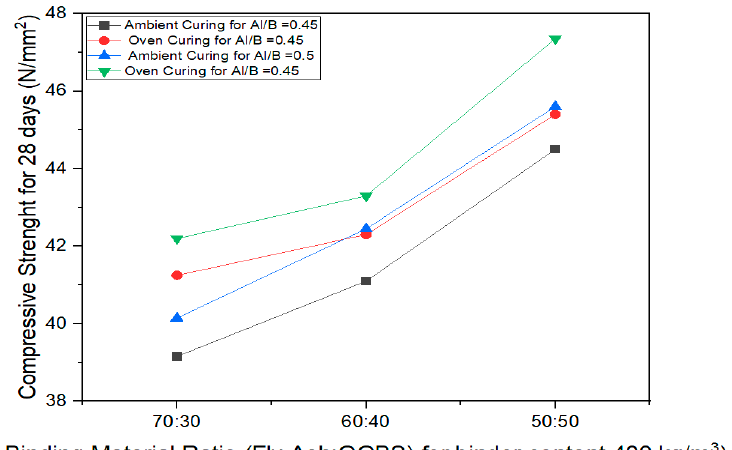
Figure 13. Strength of GPC of 400 kg/m 3 for 28 days.